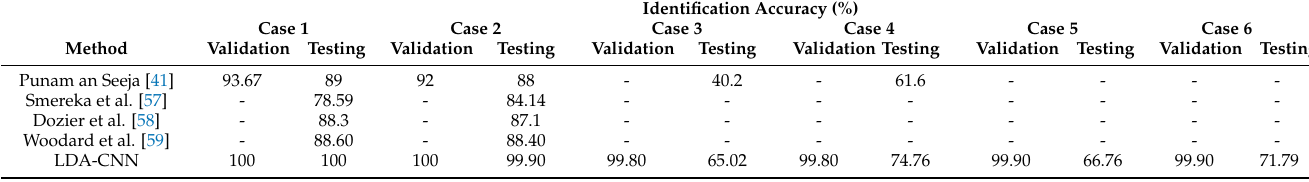
Table 10. Comparison of the results of the LDA-CNN model with other existing methods on cross- eye experiments on UBIPr using the protocol in Table 9.